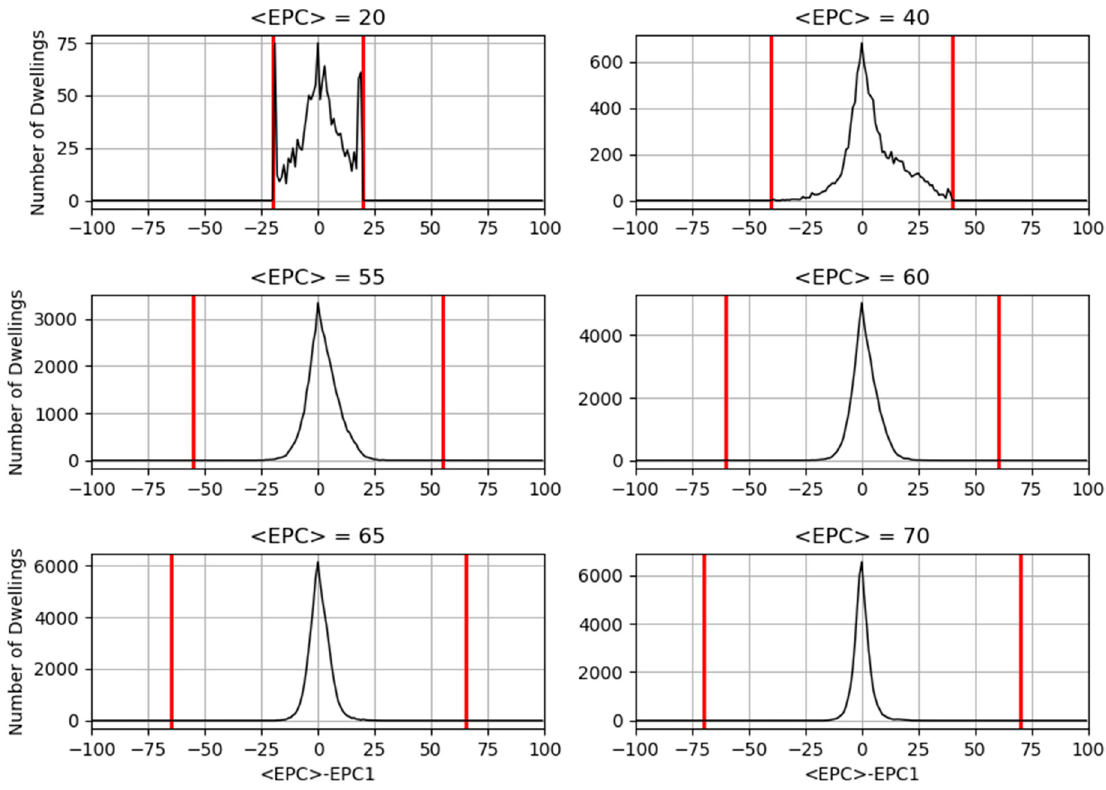
Figure 7. Spread of pairs of measurements around their mean, using subsets of data with a common < EPC > . Red vertical lines show the boundaries within which < EPC > -EPC1 must lie due to the scale boundaries.